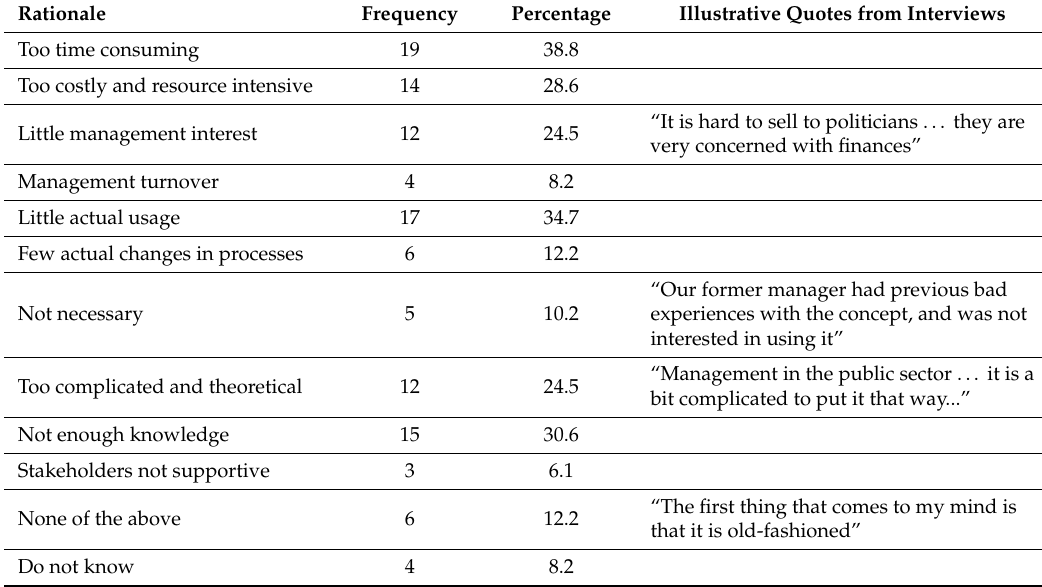
Table 11. Rationales for not adopting the BSC (N =